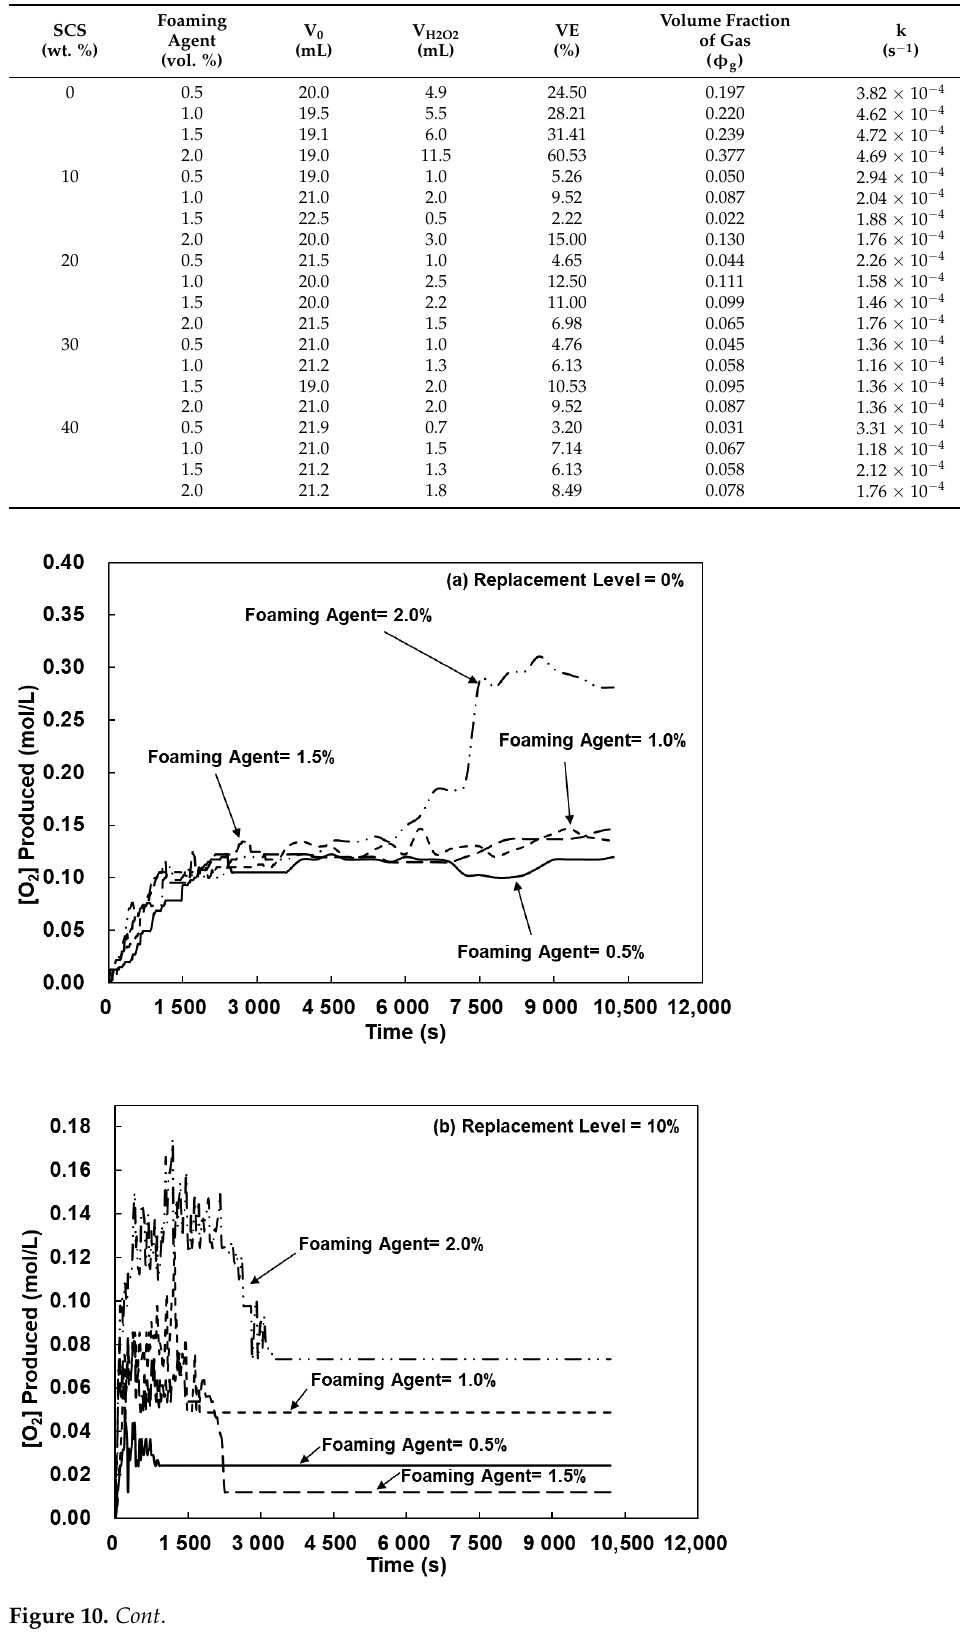
Table 6. The chemical reaction parameters and reaction rates of lightweight FGPs.